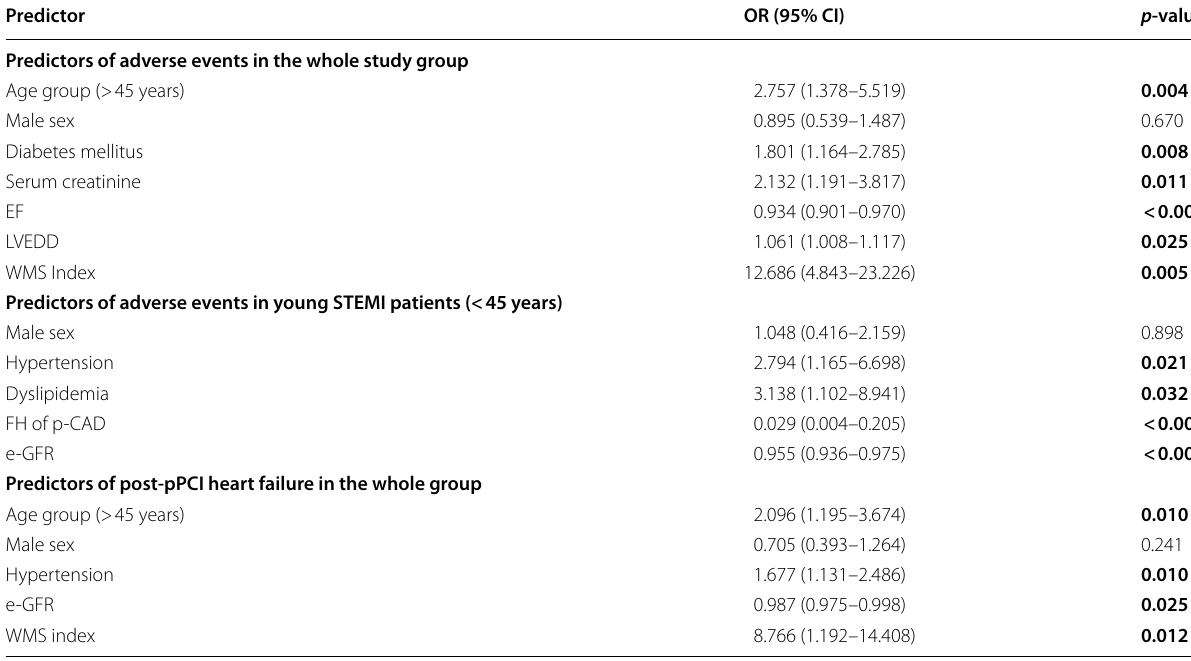
Bold values statistical significance, when p value is